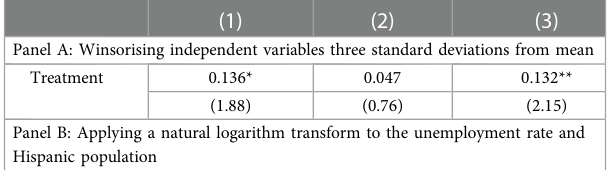
Panel B: Applying a natural logarithm transform to the unemployment rate and Hispanic population